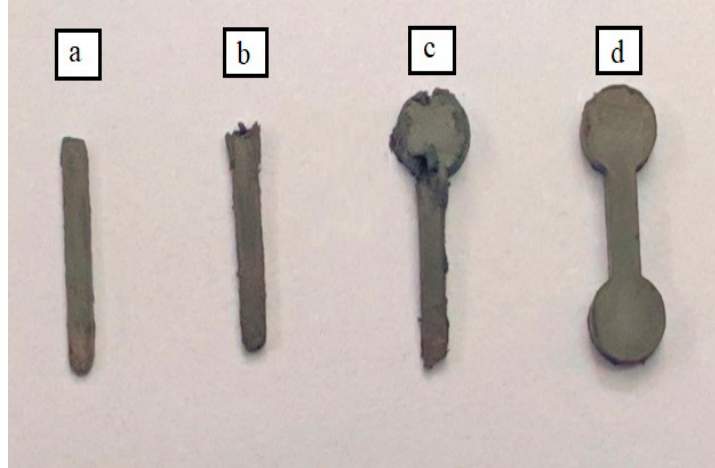
Figure 8. Injected micro-shaped SS 17-4PH parts at different mold temperatures: ( a ) 30 °C; ( b ) 35 °C; ( c ) 40 °C; and ( d ) 45 °C.